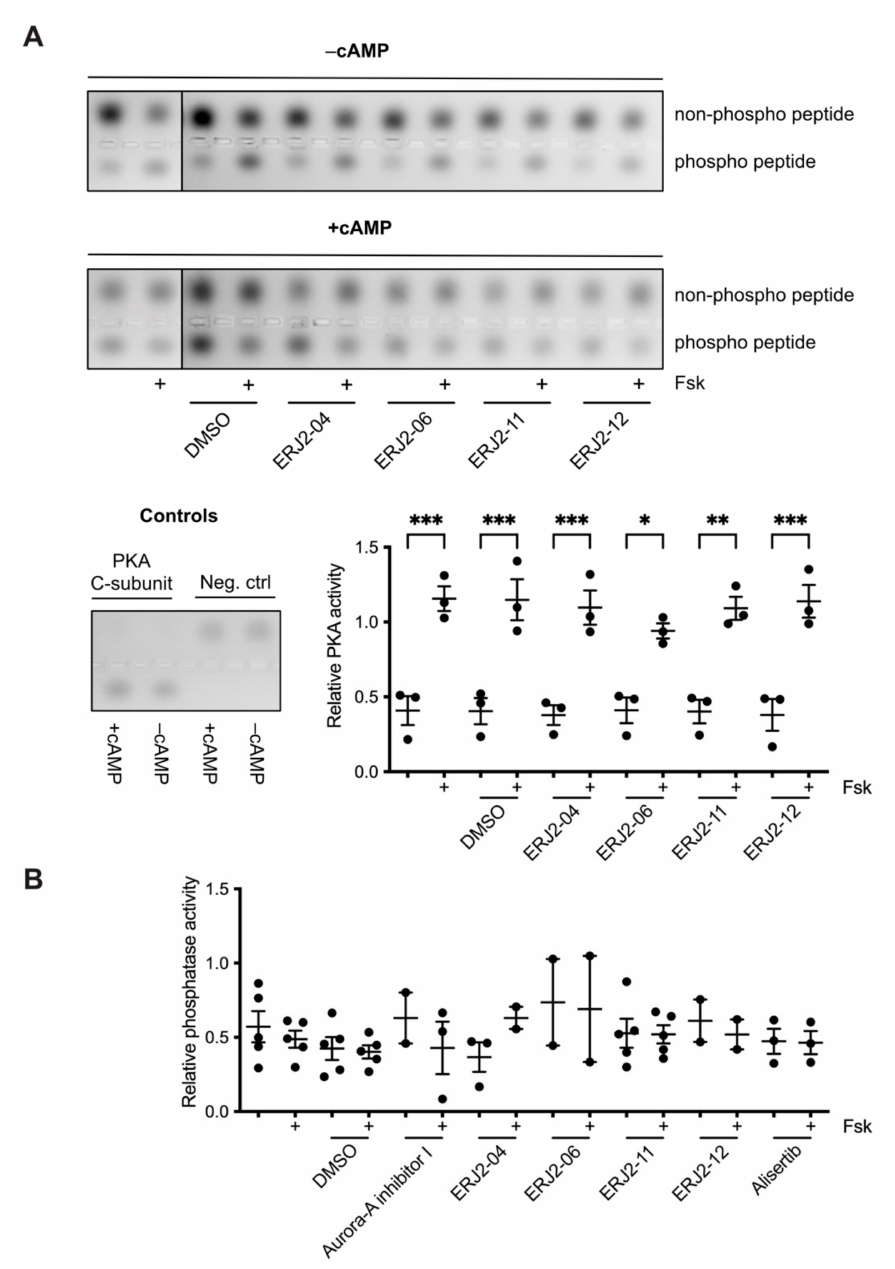
Figure 7. AURKA inhibitors do not affect global protein kinase A (PKA) or protein phosphatase activity in MCD4 cell lysates. ( A ) PKA activity in MCD4 cell lysates was determined using the PepTag